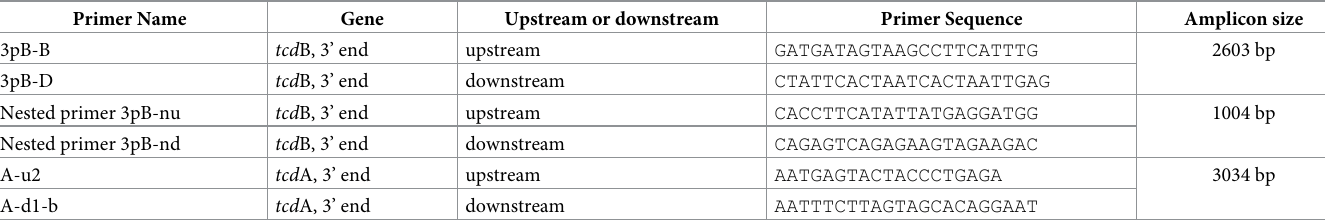
Table 2. Primers for PCR of tcd A and tcd B sequences in